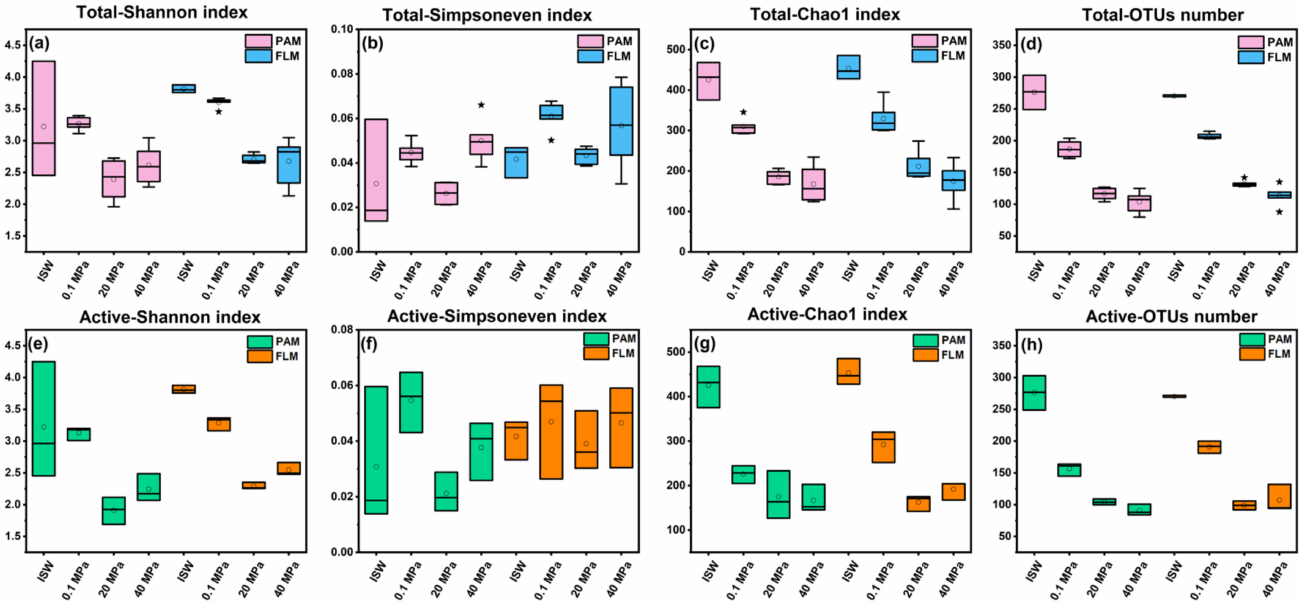
Figure 1. Alpha diversity indices (Shannon, Simpsoneven, Chao1) and OTUs number of the total and active PAM and FLM communities during POM sinking at ISW, 0.1, 20, and 40 MPa, respectively. ( a ) Total Shannon index; ( b ) total Simpsoneven index; ( c ) total Chao1 index; ( d ) total OTUs number; ( e ) active Shannon index; ( f ) active Simpsoneven index; ( g ) active Chao1 index; ( h ) active OTUs number. ISW represents in situ surface waters, hollow circle represents mean value, * represents outlier, and solid line represents